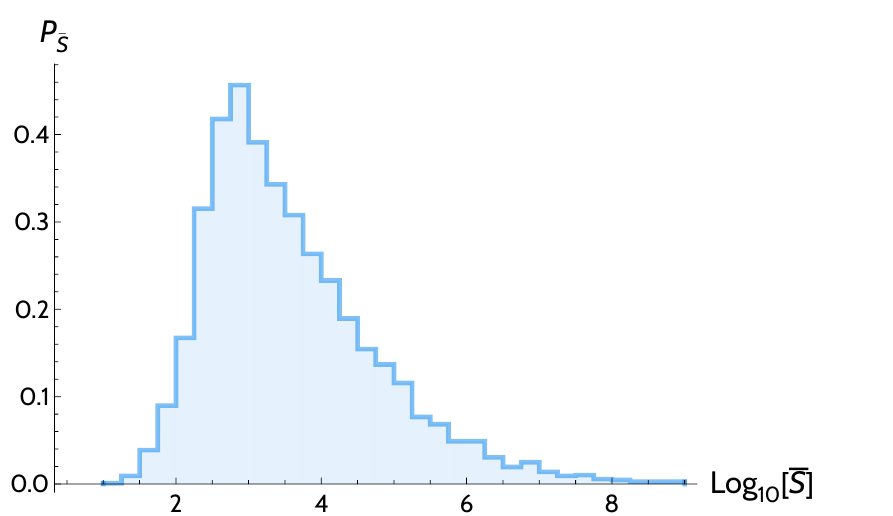
Figure 11. Distribution of the tunneling action from a minimum to the central in(cid:13)ection point, right before in(cid:13)ation begins.